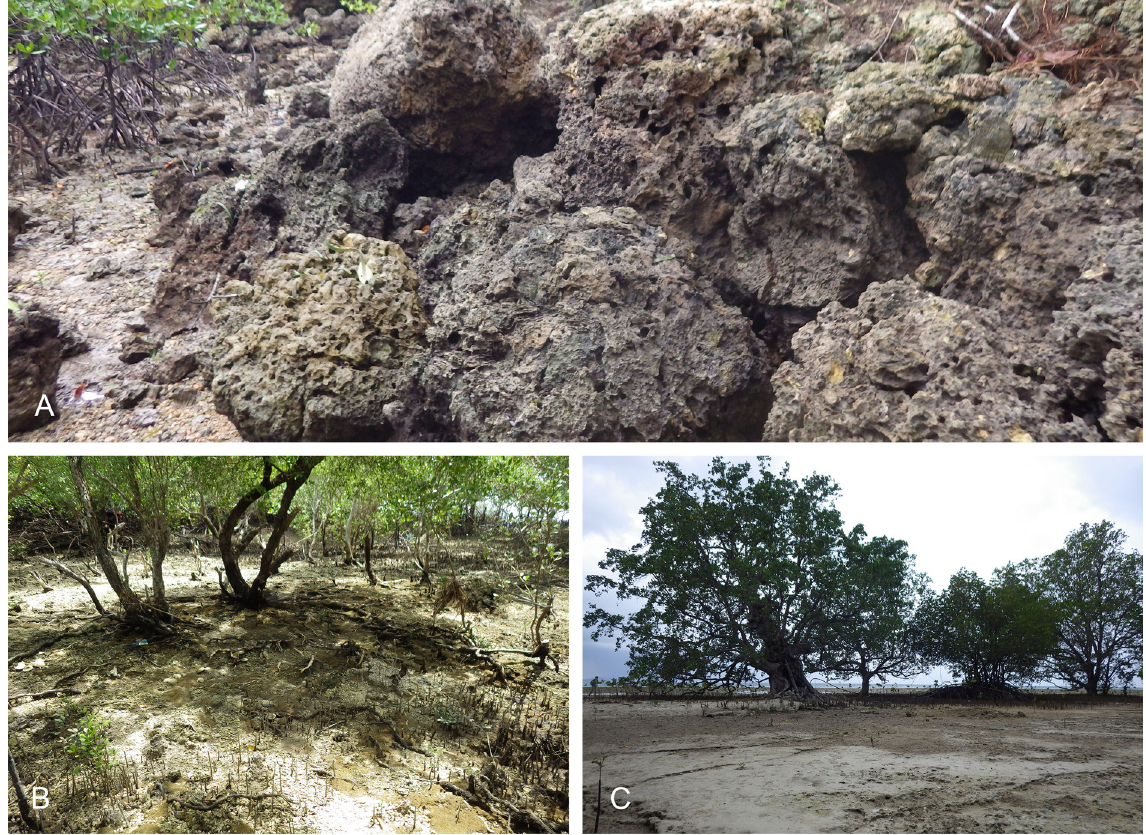
Fig. 39. Paromoionchis boholensis gen. et sp. nov., unit #1, habitats. A . Philippines, Bohol, Maribojoc, large porous rocks behind mangrove (station 193, type locality). B . Philippines, Bohol, Mabini, open Avicennia and Sonneratia forest with large gravel of coral pieces, sand and algae on surface (station 196). C . Philippines, Bohol, Maribojoc, uplifted, dead coral flat covered with sand and algae adjacent to a few mangrove trees (station